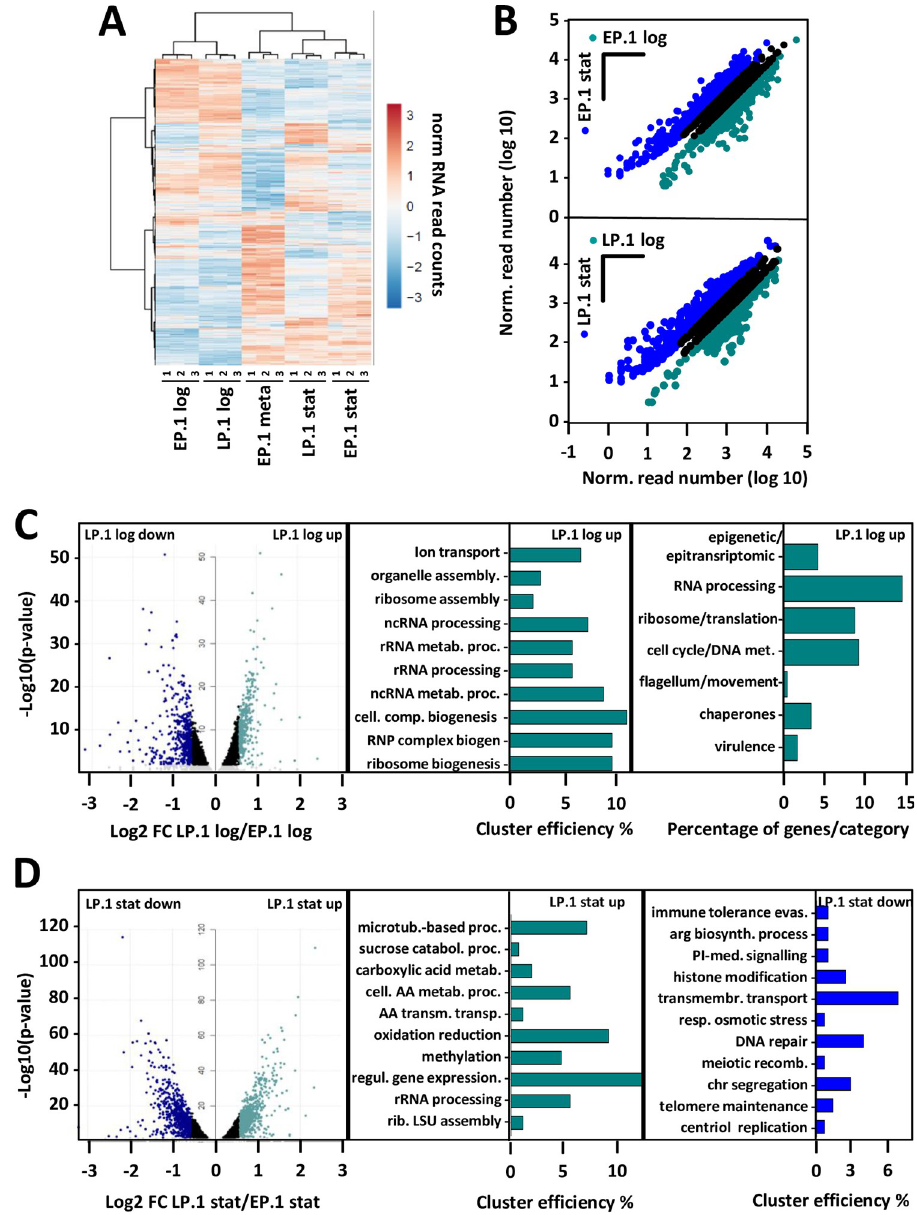
Fig 2. RNA-seq analyses of EP.1 and LP.1 promastigotes reveal stage-specific changes in RNA abundance and RNA signatures linked to fitness gain in culture and fitness cost in infectivity. (A)Cluster analysis of differentially expressed genes observed in triplicate RNAseq analyses of EP.1 log and LP.1 log, EP.1 stat and LP.1 stat, and EP.1 meta parasites. (B) Ratio plots of normalized RNAseq reads for EP.1 log compared to EP.1 stat (upper panel) and LP.1 log compared to LP.1 stat (lower panel). Blue and dark cyan dots represent gene expression changes with FC > 1.5 and adjusted p-value � 0.01; black dots correspond to gene expression changes with adjusted p-value > 0.01. Only genes with at least 10 reads in one of the two conditions were considered. Top panel, 1,499 and 1,501 transcripts more abundant in EP.1 log (dark cyan) and EP.1 stat (blue), respectively. Lower panel, 1,129 and 1,384 transcripts more abundant in LP.1 log (dark cyan) and LP.1 stat (blue), respectively (see Sheets a and d in S2 Table). (C) Differential expression profiling of LP.1 log and EP.1 log parasites. Transcripts more abundant in EP.1 log correspond to transcripts less abundant in LP.1 log. Volcano plot representing the changes in transcript abundances of LP.1 log and EP.1 log parasites with 344 transcripts more abundant in LP.1 log (LP.1 log up) versus 433 transcripts less abundant in LP.1 log (LP.1 log down) (left panel) (see Sheets g and h in S2 Table for the list of regulated genes). Transcripts with significant increased abundance FC > 1.5 and adjusted p-value � 0.01 in LP.1 log up and LP.1 log down are indicated respectively in cyan and blue and were used to perform the GO analysis for the category ‘biological process’.